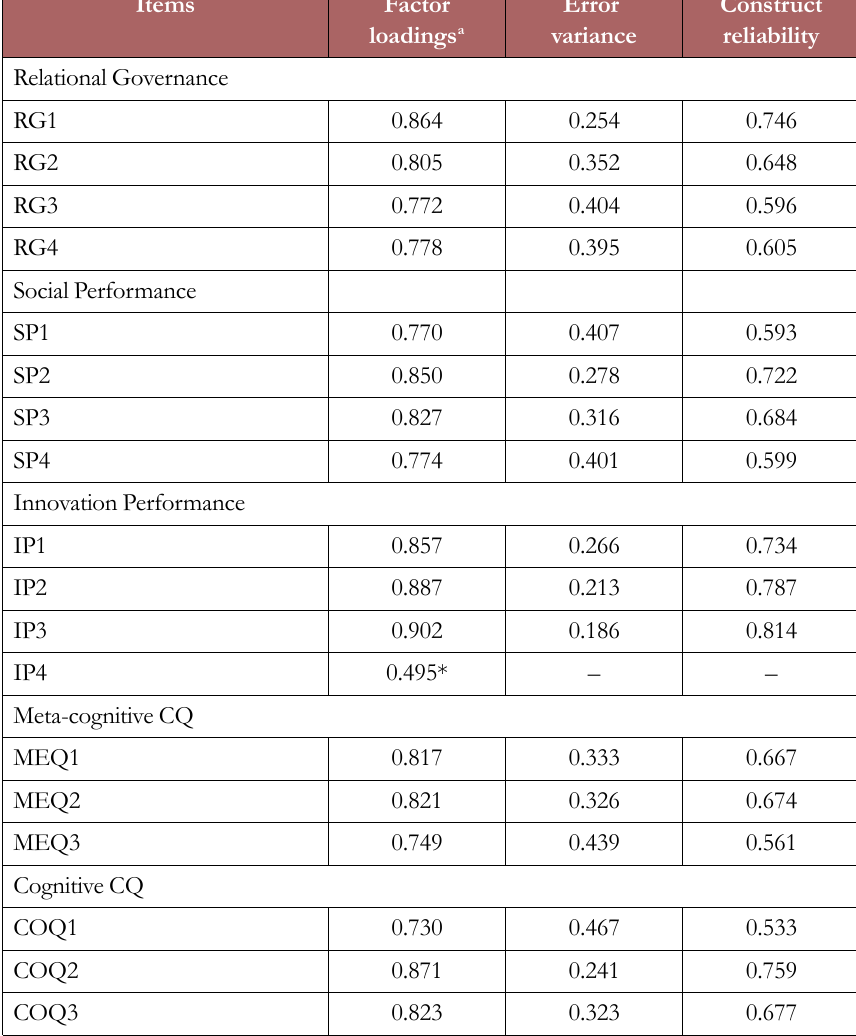
Table 2. Validation of constructs Survey items, item means, standard